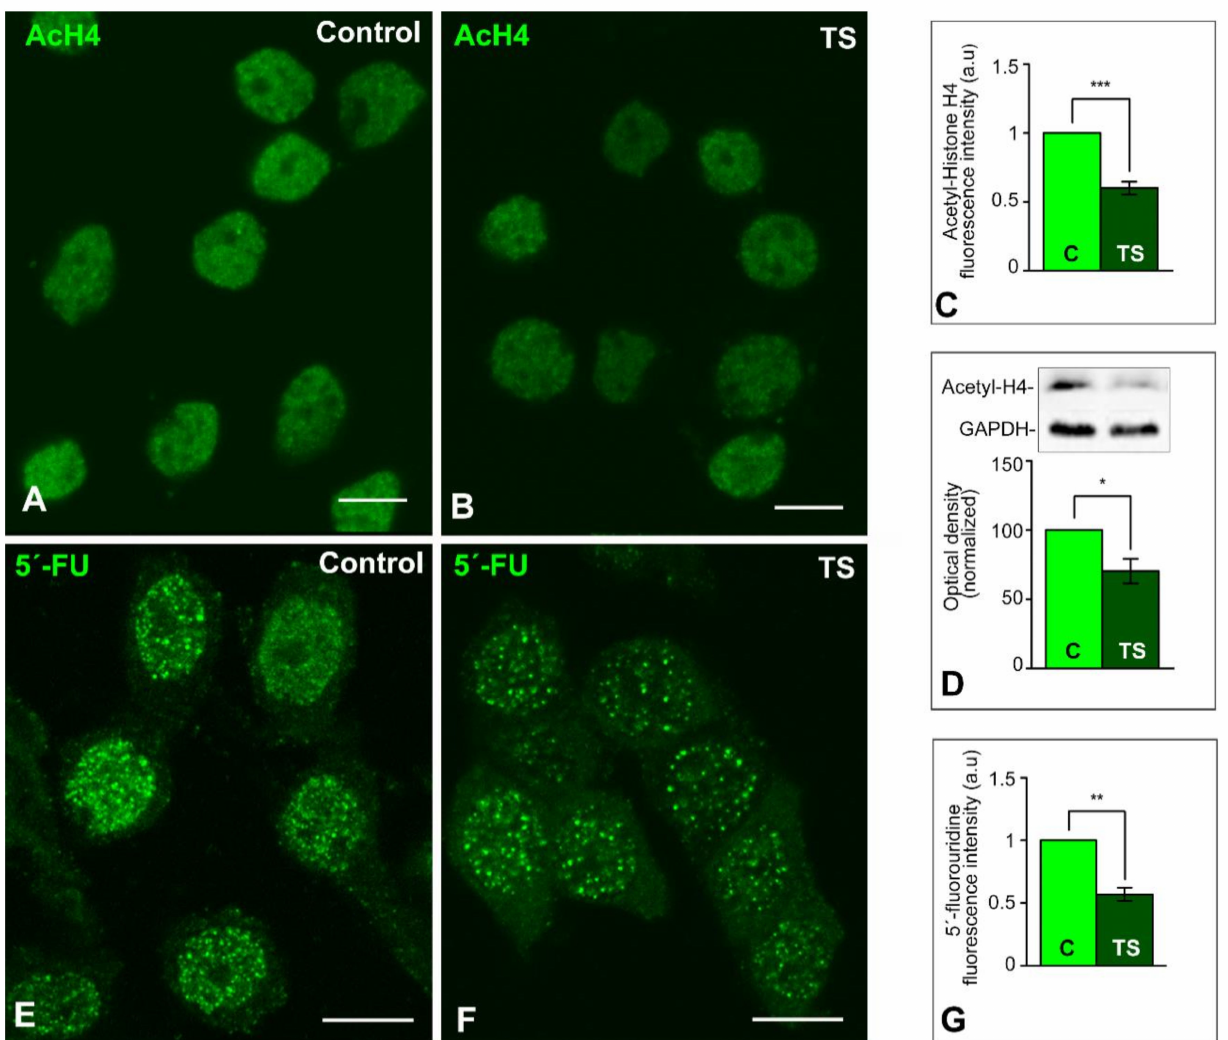
Figure 2. Global transcription rate is reduced in the GCs of TS mice . ( A , B ) Nuclear immunostaining of the acety- lated histone H4 in dissociated GCs from control ( A ), and TS ( B ) mice. This acetylated histone appears diffusely dis- tributed throughout the nucleus, excluding the nucleolus, with a higher intensity of fluorescent signal in control GCs. Scale bars: 5 µ m. ( C ) Densitometric analysis reveals a significant increase of acetylated histone H4 signal intensity in control GC nuclei as compared with TS ones. ( D ) Down-regulation of acetylated histone H4 expression in the hippocampi of TS mice relative to control animals as shown by Western blotting. GADPH was used as loading control. ( E , F ) In situ transcription assay with 5 (cid:48) -fluorouridine illustrates the nuclear incorporation of this halogenated precursor into nascent RNA from control ( E ), and TS ( F ) GCs. Note the higher abundance of microfoci of high fluorescent signal intensity of RNA (transcription factories) in control GC nuclei. Scale bars: 5 µ m. ( G ) Densitometric analysis reveals a significant increase of 5 (cid:48) -fluorouridine incorporation signal intensity in control GC nuclei as compared with TS ones. C, D, G: Data is presented as means + SEM of three independent experiments. *: p < 0.05, **: p < 0.01, ***: p < 0.001. AcH4 = acetylated histone H4; C = control mice; 5 (cid:48) -FU = 5 (cid:48) -fluorouridine; TS = Ts65Dn